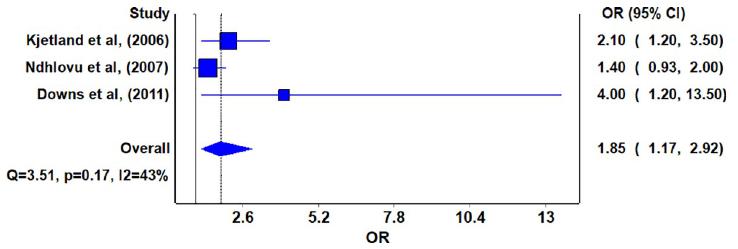
Fig 3. Forest plot of impact of Urogenital schistosome infection to HIV infection in papers with adjusted OR.